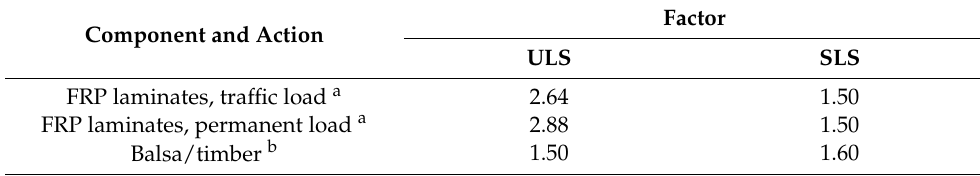
Table 3. Material factors used in the design. Component and Action